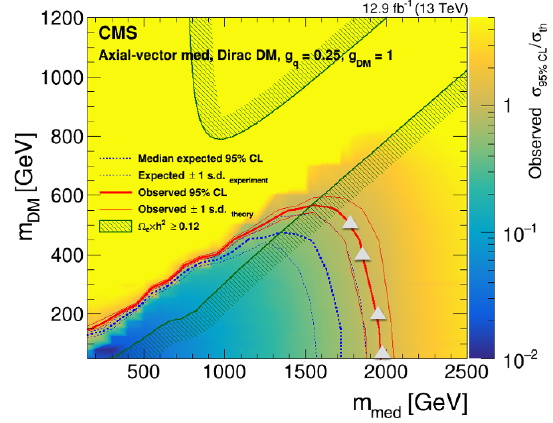
Figure 3 . The grey triangles, superimposed on the CMS limit, show 95% C.L. lower limits on the mediator mass m med for some values of m . The (cid:12)gure is obtained within the benchmark model DM employed by CMS in ref. [34] and for benchmark values, reported on the plot, of its